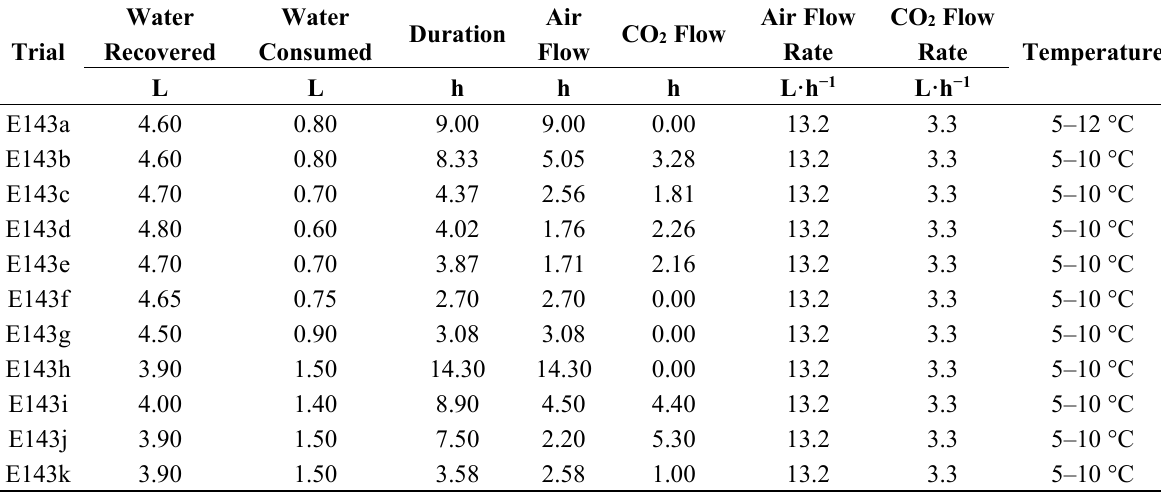
Table C7. ZVM TPA Example (Trial E143): Product Water Volume Recovered, Trial Duration, Temperature, Gas Flows.